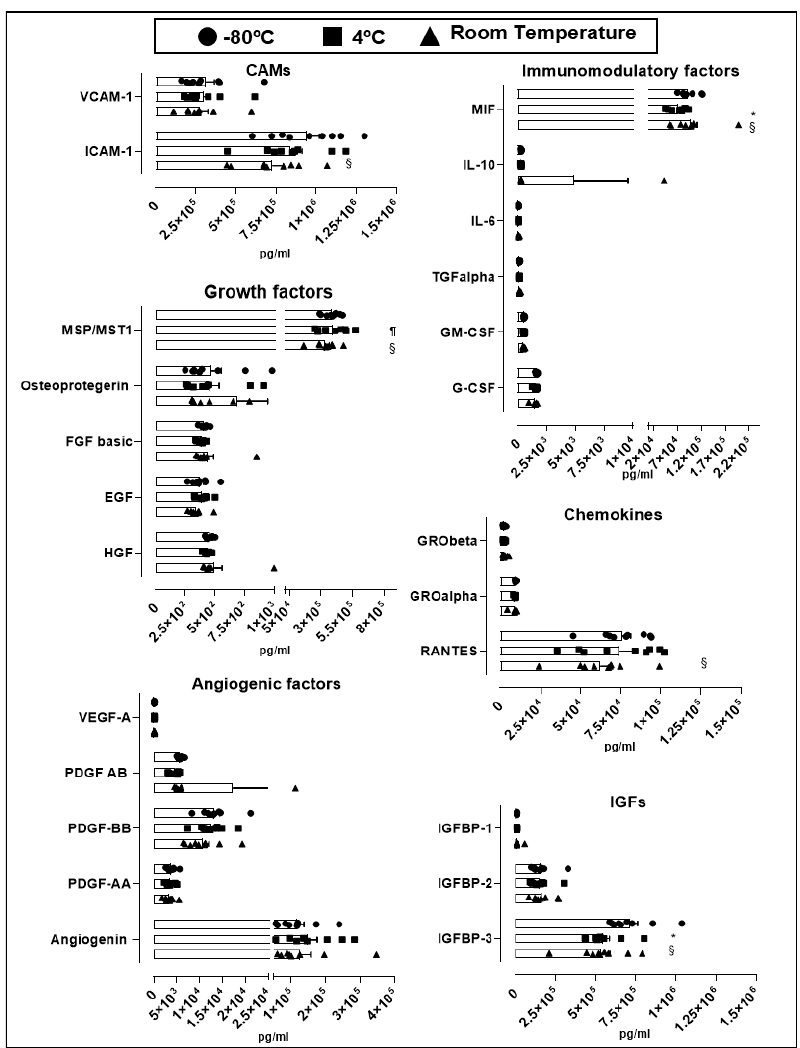
Figure 3. Stability of soluble factors at different storage conditions. Soluble factors were grouped by cellular adhesion molecule (CAMs), angiogenic factors, growth factors, insulin-like growth factors (IGFs), immunomodulatory factors and chemokines. Three storage conditions at − 80 °C (circle, n = 9), 4 °C (square, n = 9) and room temperature (triangle, n = 9) were evaluated. Data is represented as mean ± SEM. § p < 0.05 − 80 °C vs. room temperature, ¶ p < 0.05 4 °C vs. room temperature, * p < 0.05 − 80 °C vs. 4 °C, analyzed by Tukey’s test.